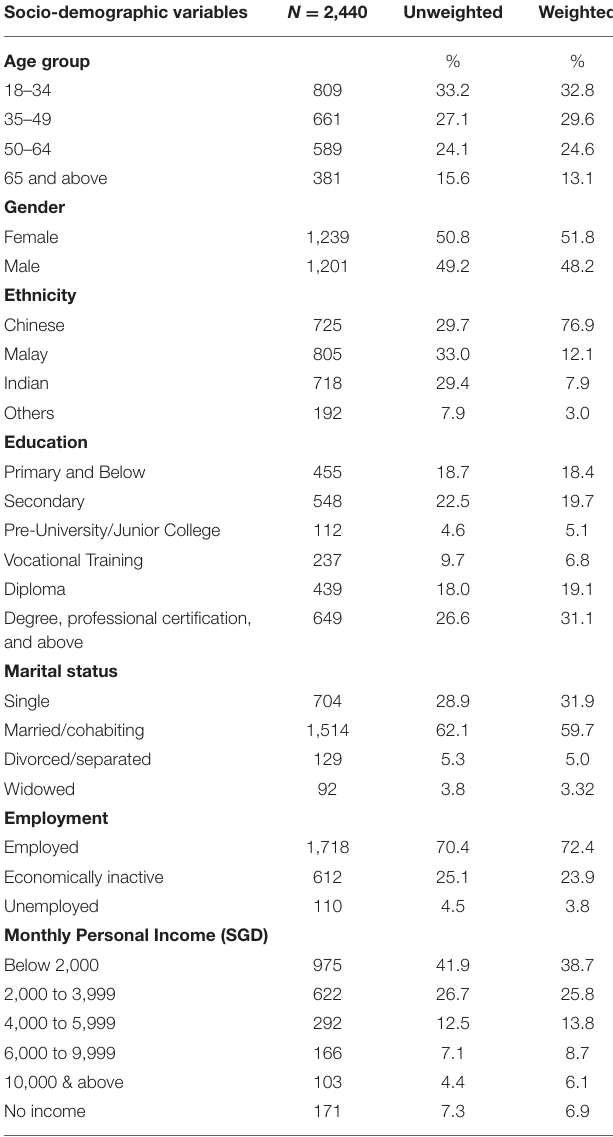
TABLE 1 | Socio-demographic characteristics of the